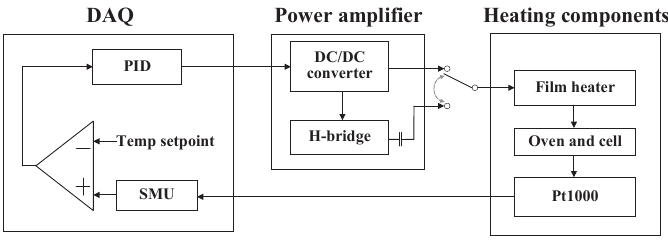
Figure 3. Schematic of the heating system of the atomic magnetometer. Temp: temperature; SMU: source measure unit.